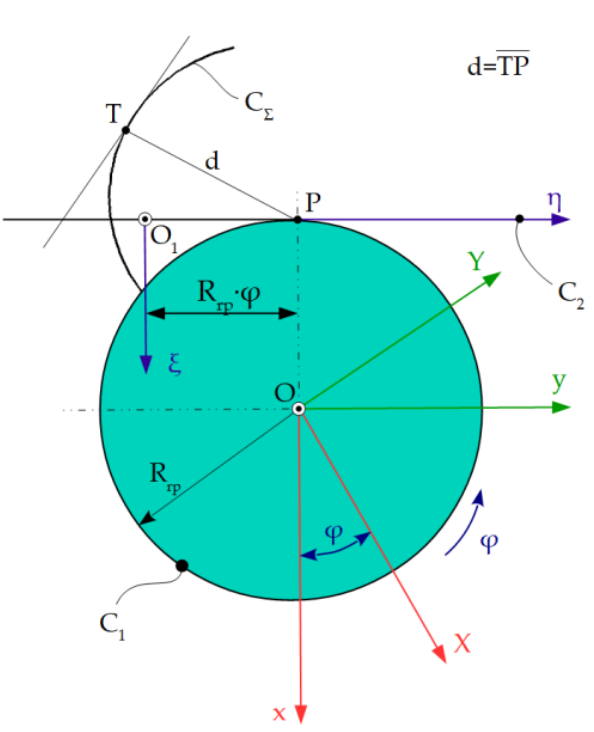
Figure 4. Minimum distance method applied to rack tool generating [12].